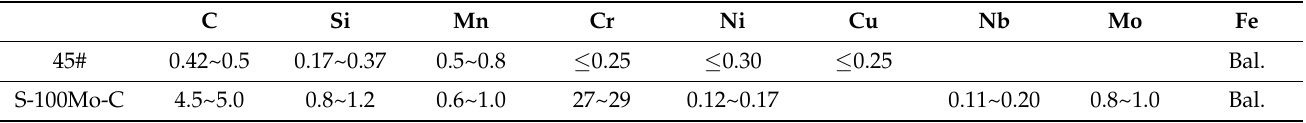
Table 2. Chemical composition of the base metal and welding